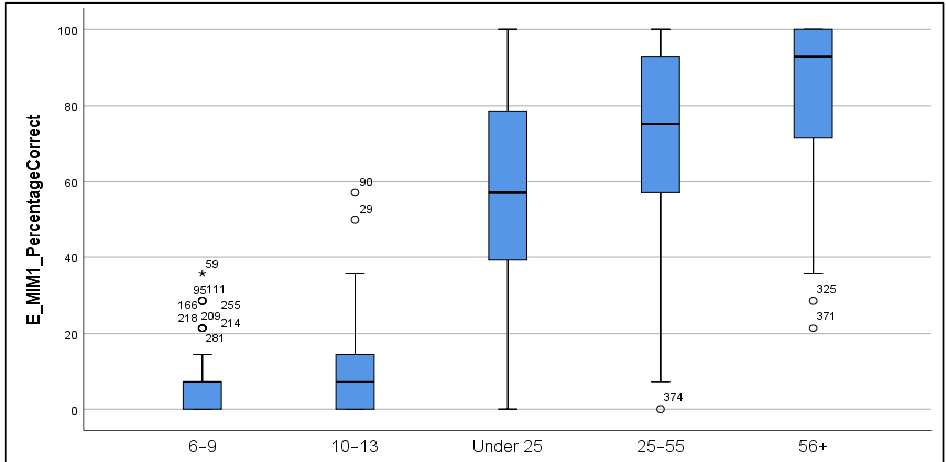
Figure 6. E-MIM Subtest 1 (Det + N): Accuracy of child and adult participants by age (* = extreme value).